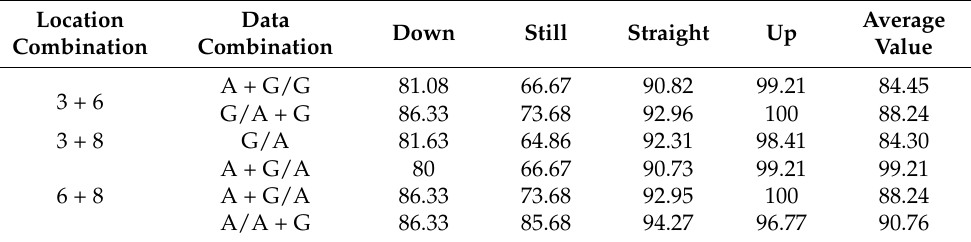
Table 6. The F-measure value of the best recognition model of two-position fusion inertial sensors— Classified lifting